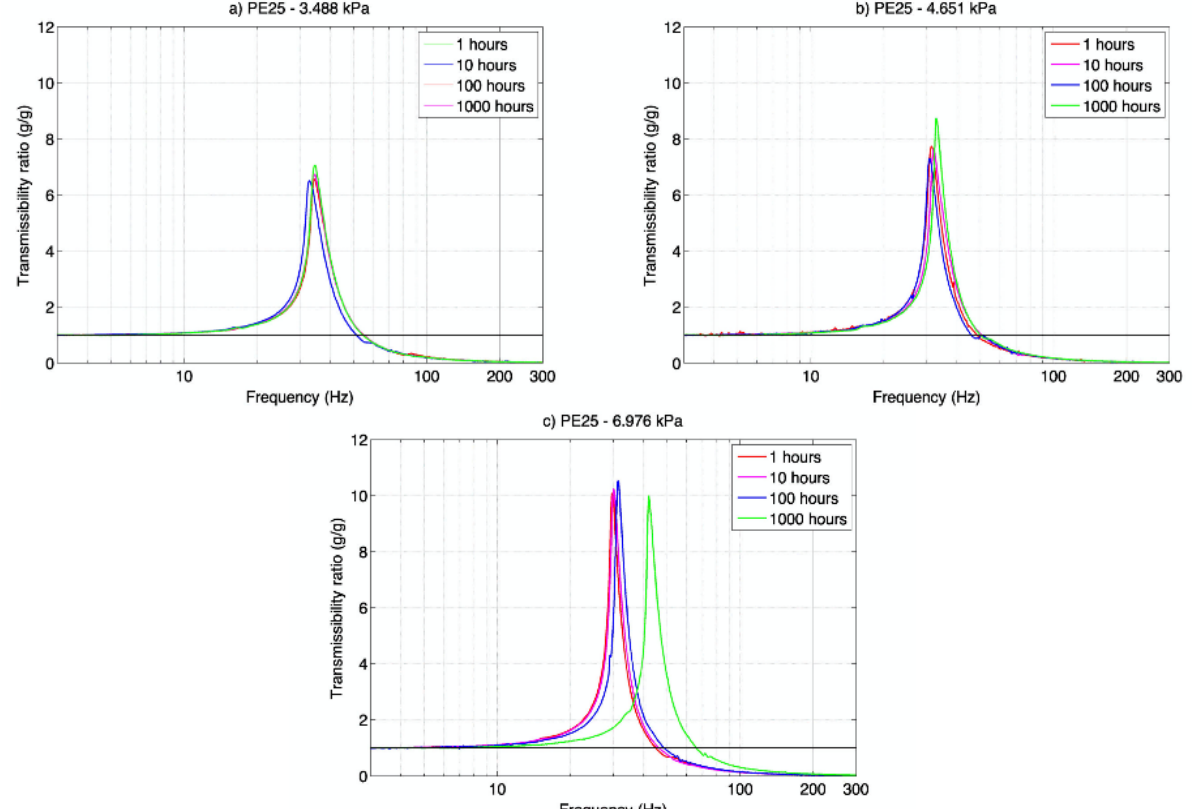
Figure 5. Vibration transmissibility and frequency curve for (a) PE25 at a static load of 3.488 kPa, for (b) PE25 at a static load of 4.651 kPa, for (c) PE25 at a static load of 6.976 kPa